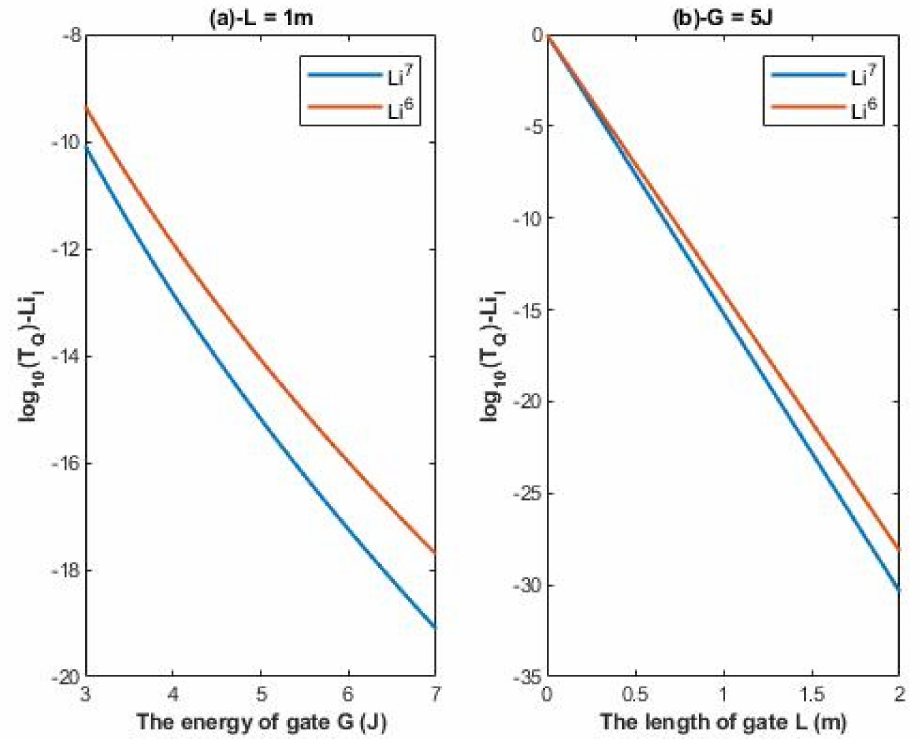
Figure 3. ( a ): The figure represents the relationship between the common logarithm of tunneling probability of the intracellular lithium isotopes log L = 1 m and across the range of G from 3 J to 7 J. ( b ): The figure represents the relationship between the common logarithm of tunneling probability of the intracellular lithium isotopes log and the length of the gate L by setting G = 5 J and across the range of L from 0 m to 2